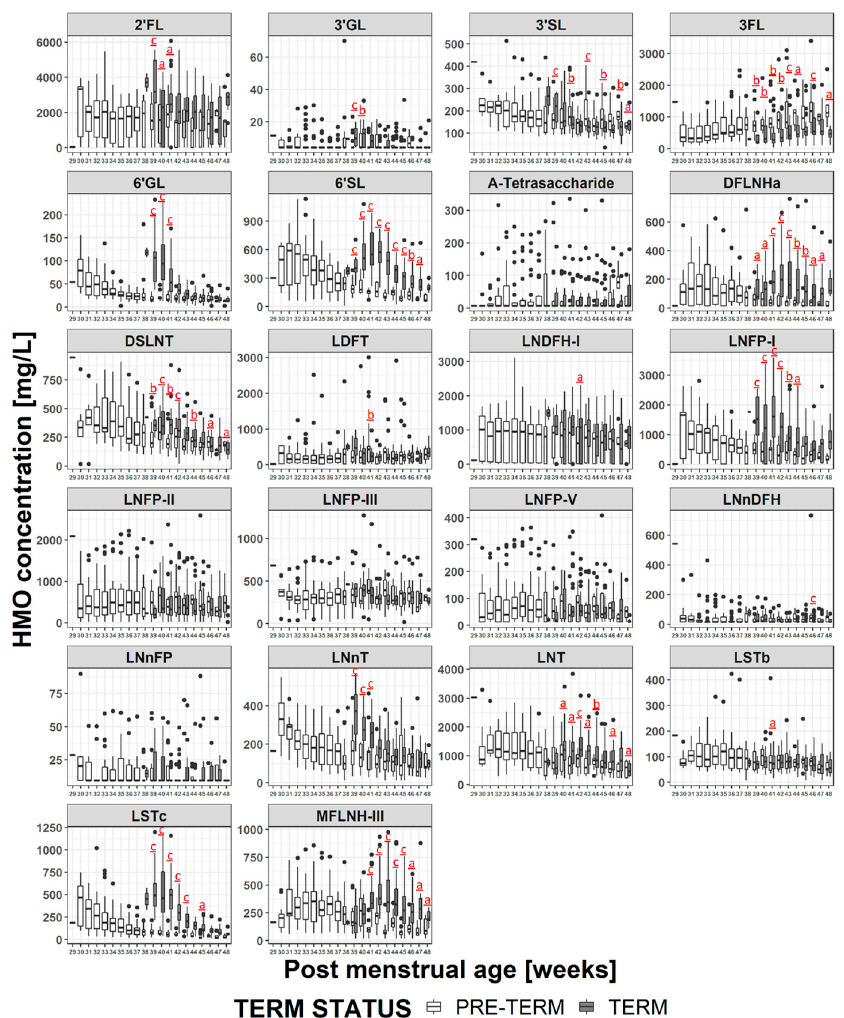
Figure 6. Comparison of the HMO concentration in the milk of mothers giving birth to term (grey bars) or preterm (white bars) infants at equivalent postmenstrual age. a: p < 0.05, b: p < 0.005 c: p < 0.0005.